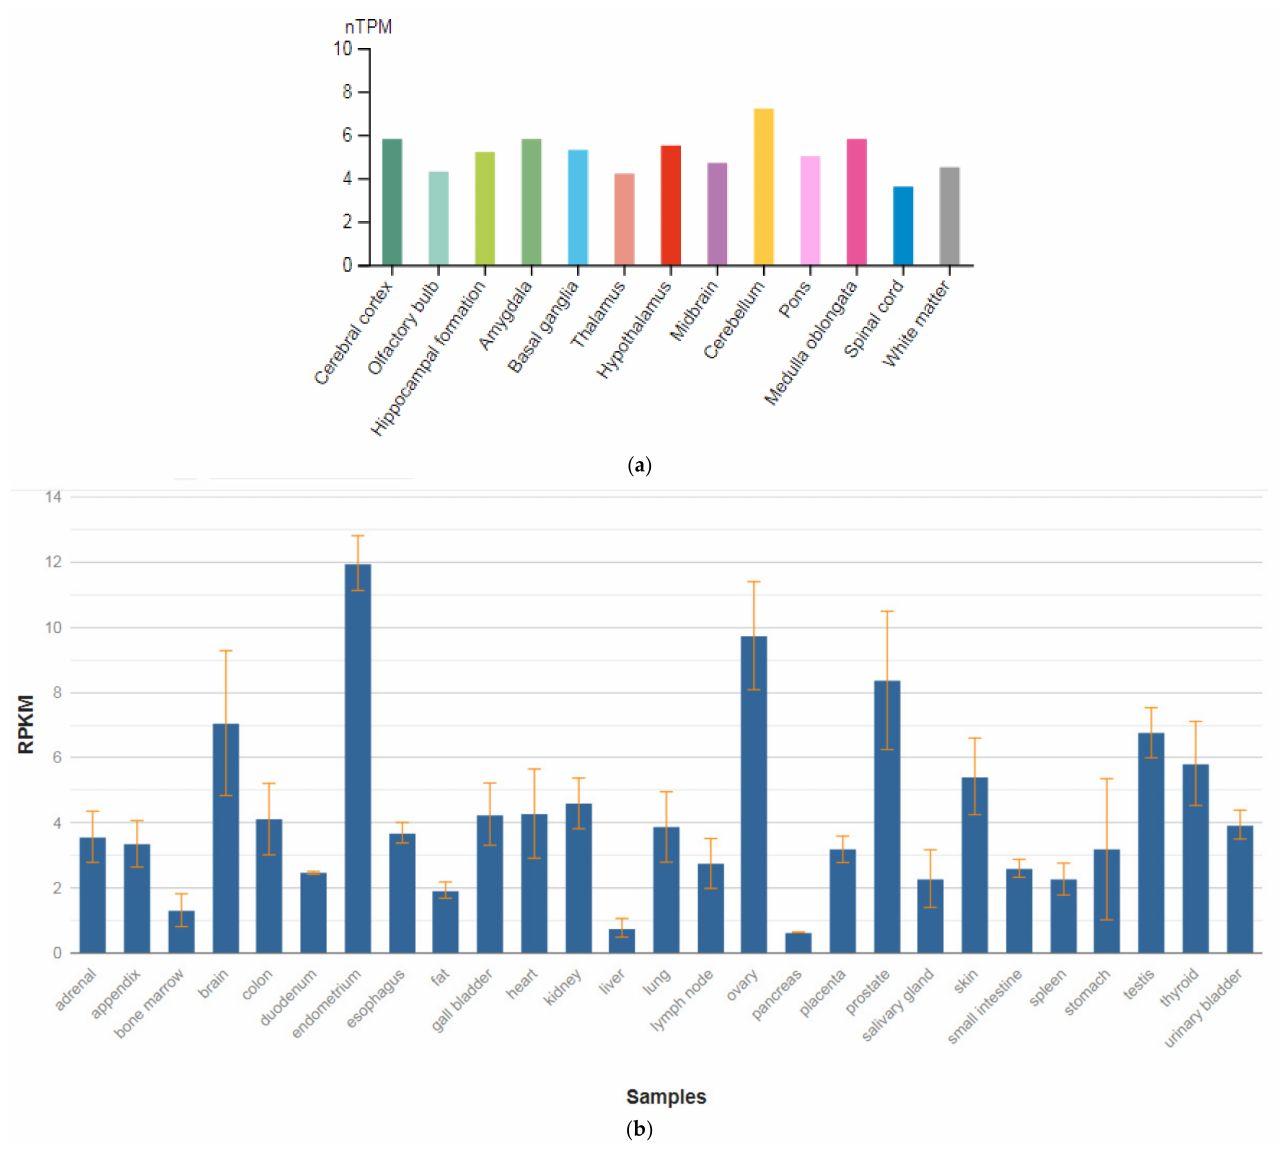
Figure 9. The tissue expression of the BCL6 transcription repressor in the brain ( a ) and other organs in the human body ( b